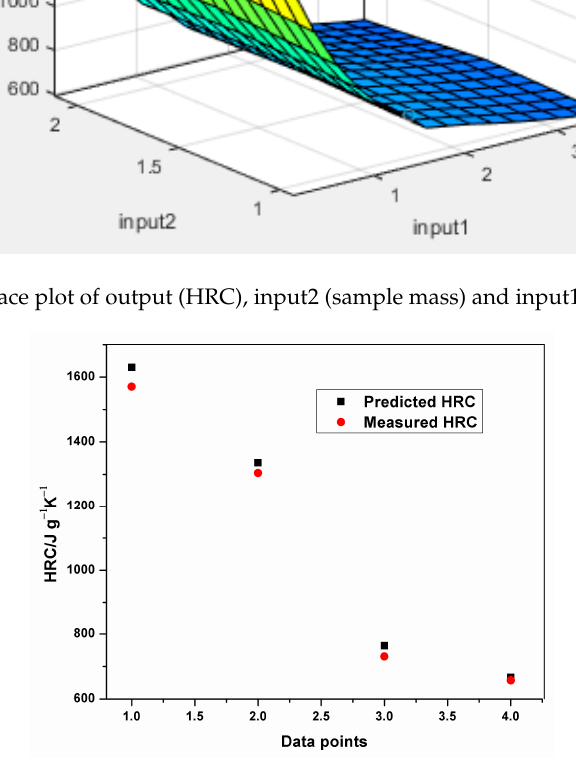
Figure 8. Plot of predicted and measured HRC for